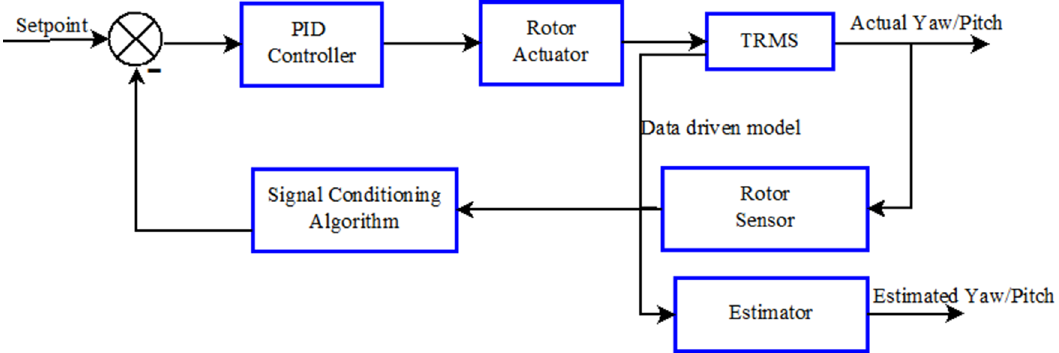
Figure 4. Block diagram of the closed-loop Twin Rotor MIMO system.